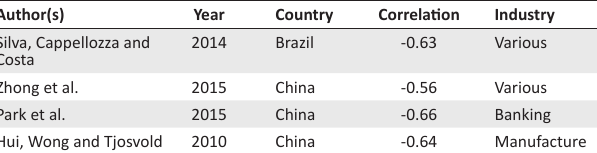
TABLE 1: Relationship between perceived organisation support and turnover